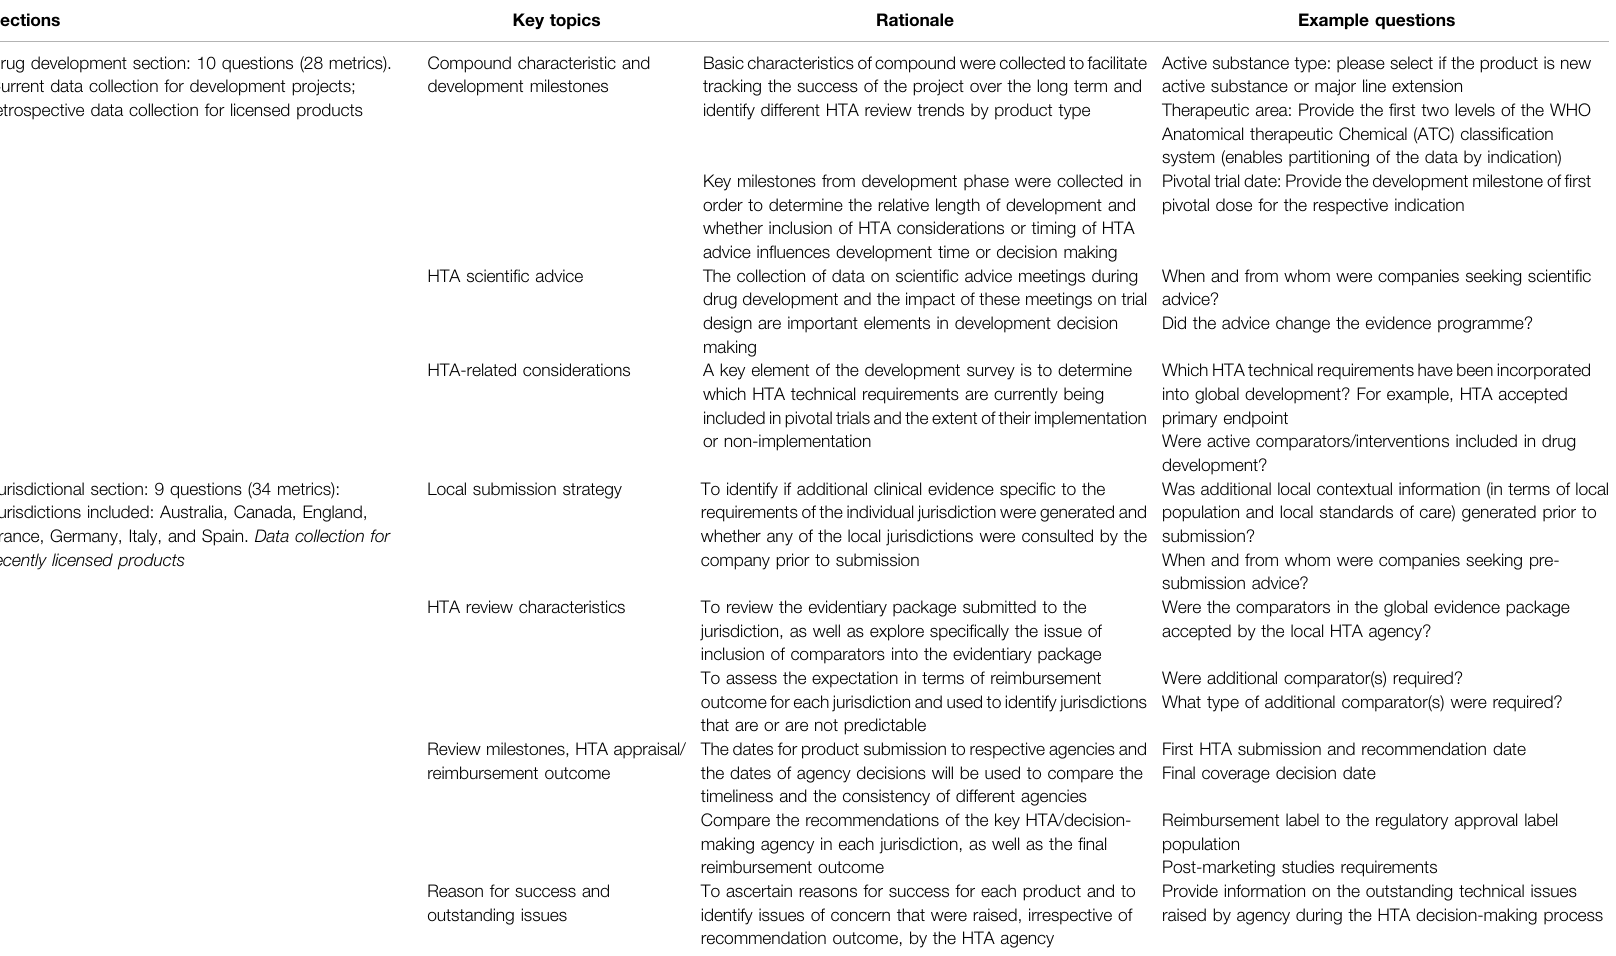
TABLE 2 | Structure of the